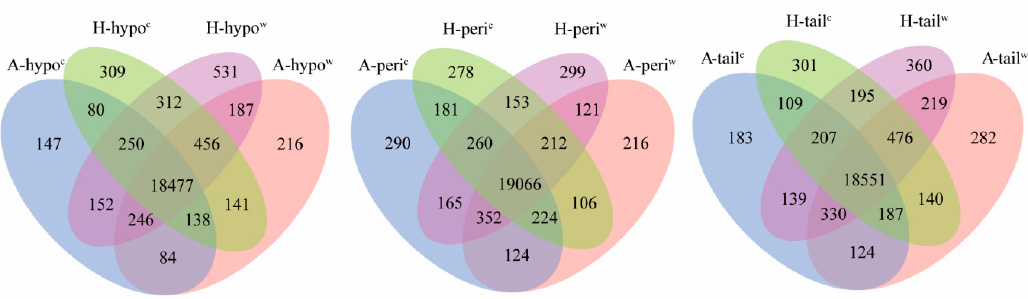
Figure 3. Venn diagrams representing annotated genes in hypothalamus tissue, tail-fat tissue and perirenal fat tissue of cold-exposed Altay and Hu lambs; A-hypo c : hypothalamus tissue of − 5 °C Altay lambs; H-hypo c : hypothalamus tissue of − 5 °C Altay lambs; A-hypo w : hypothalamus tissue of 20 °C Altay lambs; H-hypo w : hypothalamus tissue of 20 °C Hu lambs. A-peri c : perirenal fat tissue of − 5 °C Altay lambs; H-peri c : perirenal fat tissue of − 5 °C Altay lambs; A-peri w : perirenal fat tissue of 20 °C Altay; H-peri w : perirenal fat tissue of 20 °C Hu lambs. A-tail w : tail-fat tissue of − 5 °C Altay lambs; H-tail c : tail-fat tissue of − 5 °C Altay lambs; A-tail w : tail-fat tissue of 20 °C Altay lambs; H-tail w : tail-fat tissue of 20 °C Hu lambs.